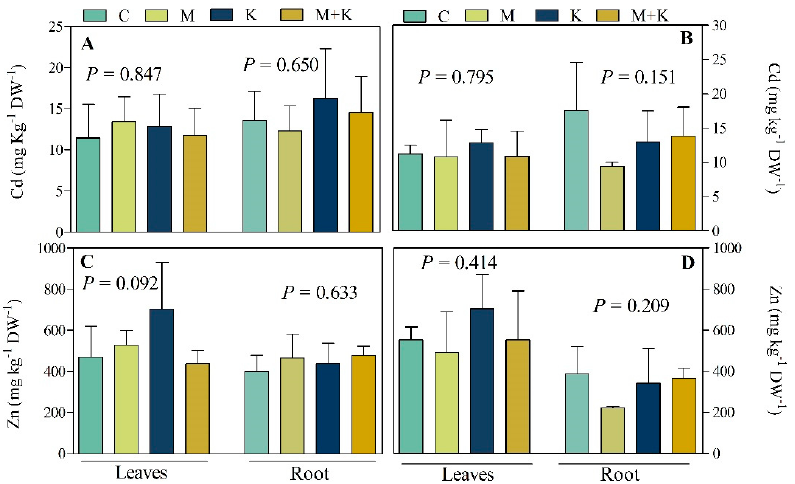
Figure 5. Cd and Zn concentrations (mg kg − 1 dry weight) in leaves and roots of cuttings of Populus cultivars ‘Dender’ ( A , C ) and ‘Marke’ ( B , D ) after 6 weeks of growth in trace elements polluted soil. Ctrl (control): Non-inoculated cuttings; M: Methylobacterium sp. CP3 inoculation; K: Kineococcus endophyticus CP19 inoculation; M+K: Methylobacterium sp. CP3 and Kineococcus endophyticus CP19 inoculation. Statistical significance was determined with one-way ANOVA followed by Tukey’s Multiple Comparison Test ( p < 0.05).